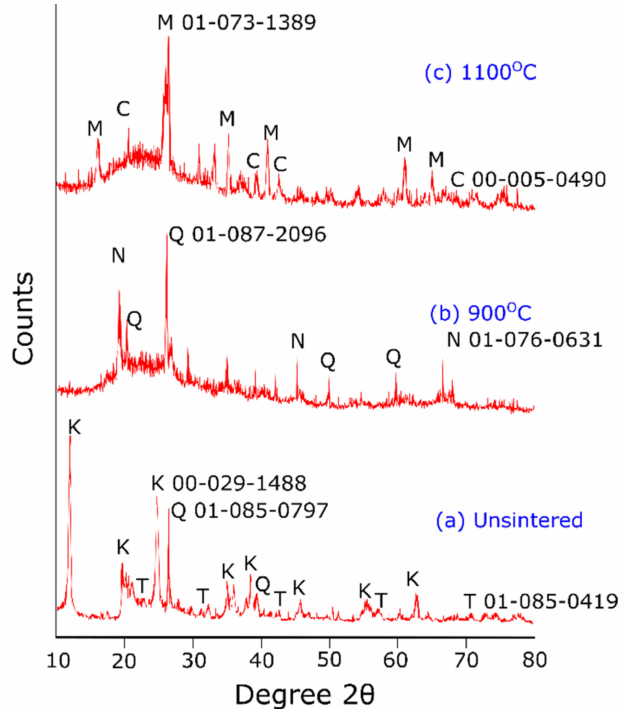
Figure 9. Phase transformation of kaolin geopolymer when ( a ) unsintered, ( b ) sintered at 900 ◦ C, and ( c ) sintered at 1100 ◦ C. M, mullite; C, cristobalite; Q, quartz; K, kaolin; N, nepheline; T,